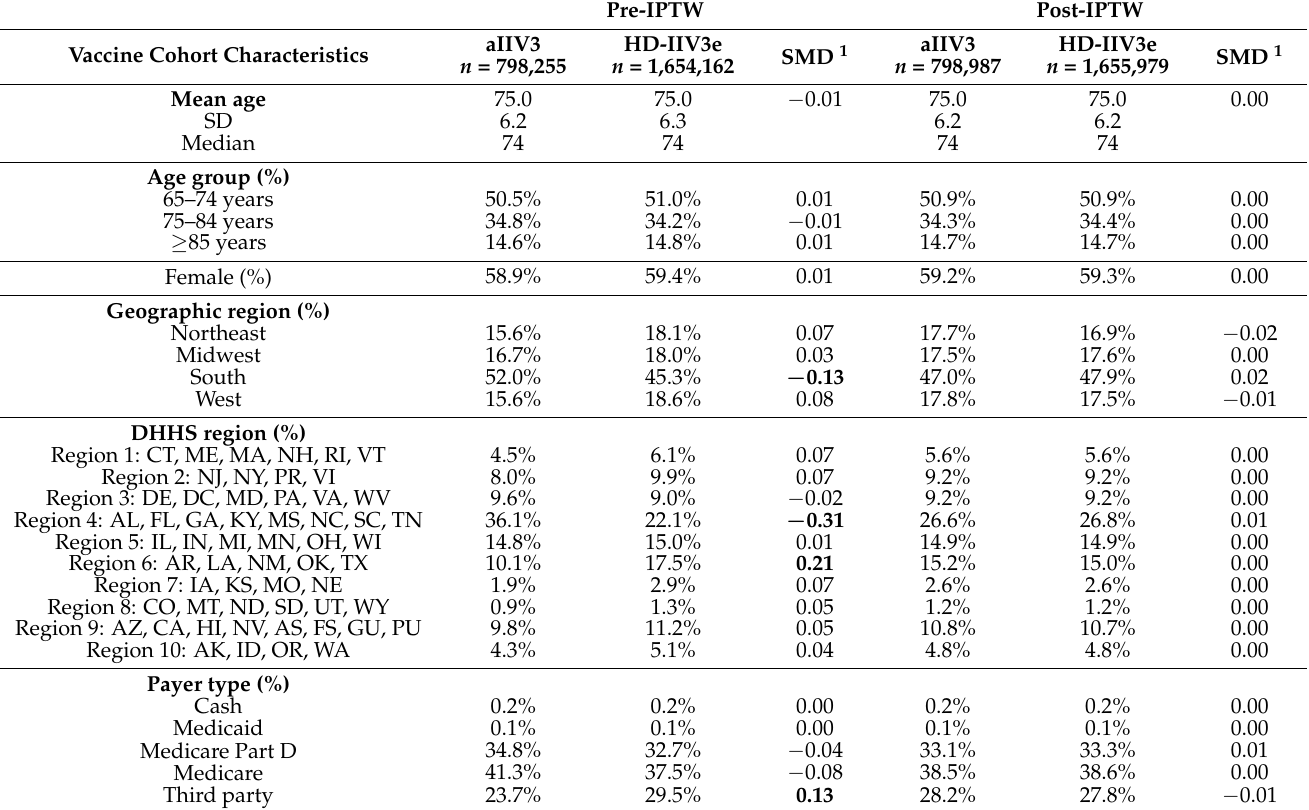
Table 1. Baseline Demographic Characteristics—Pre- and